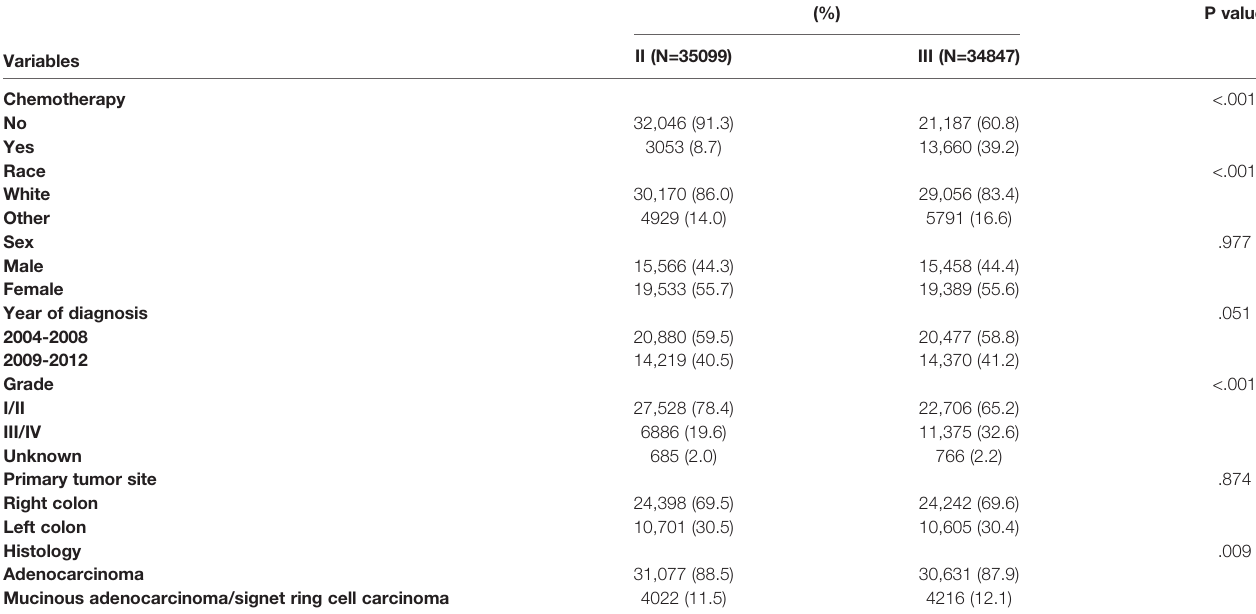
TABLE 2 | Clinicopathological characteristics of colon cancer patients by stage group.